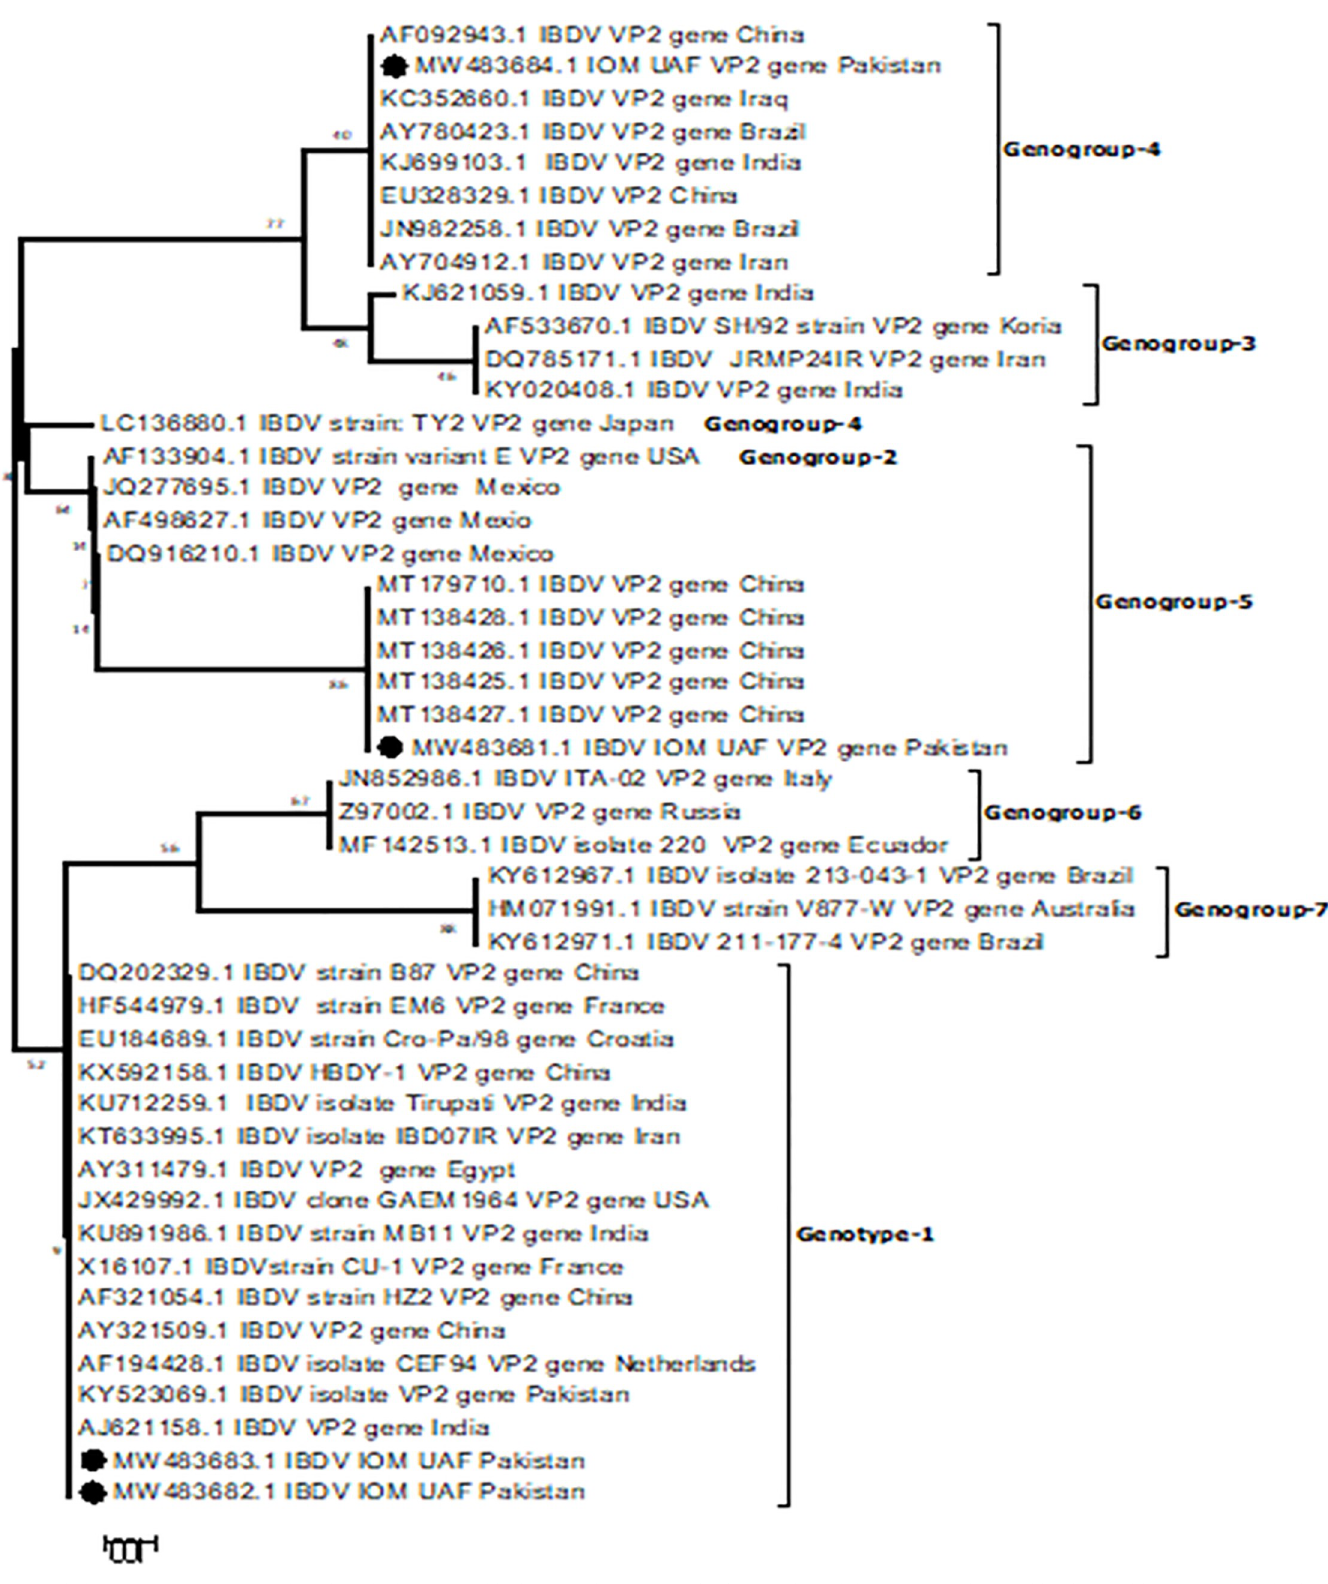
Fig 4. Phylogenetic consensus tree based on the hypervariable domain of VP2 gene of infectious bursal disease virus, designed by the neighbor-joining method using Clustal W alignment of the nucleotides created in Mega-6. https://doi.org/10.1371/journal.pone.0254605.g004 PLOS ONE | https://doi.org/10.1371/journal.pone.0254605 August 16,